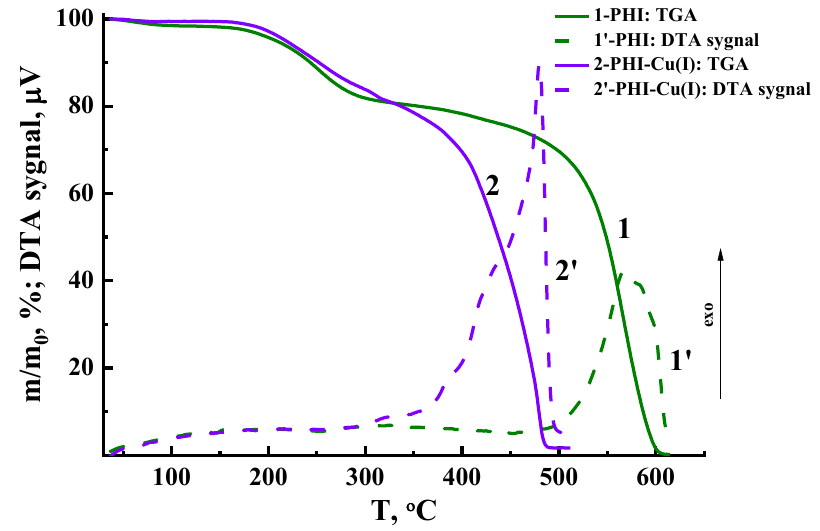
Figure 6. TGA and DTA curves of PHI and PHI-Cu(I) films. Table 2. Characteristics of thermal stability of the